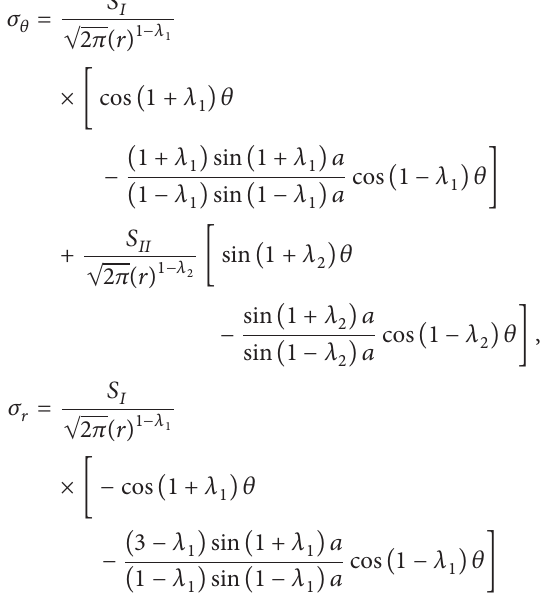
Figure 4: The equivalent stress change rate of the selected points.